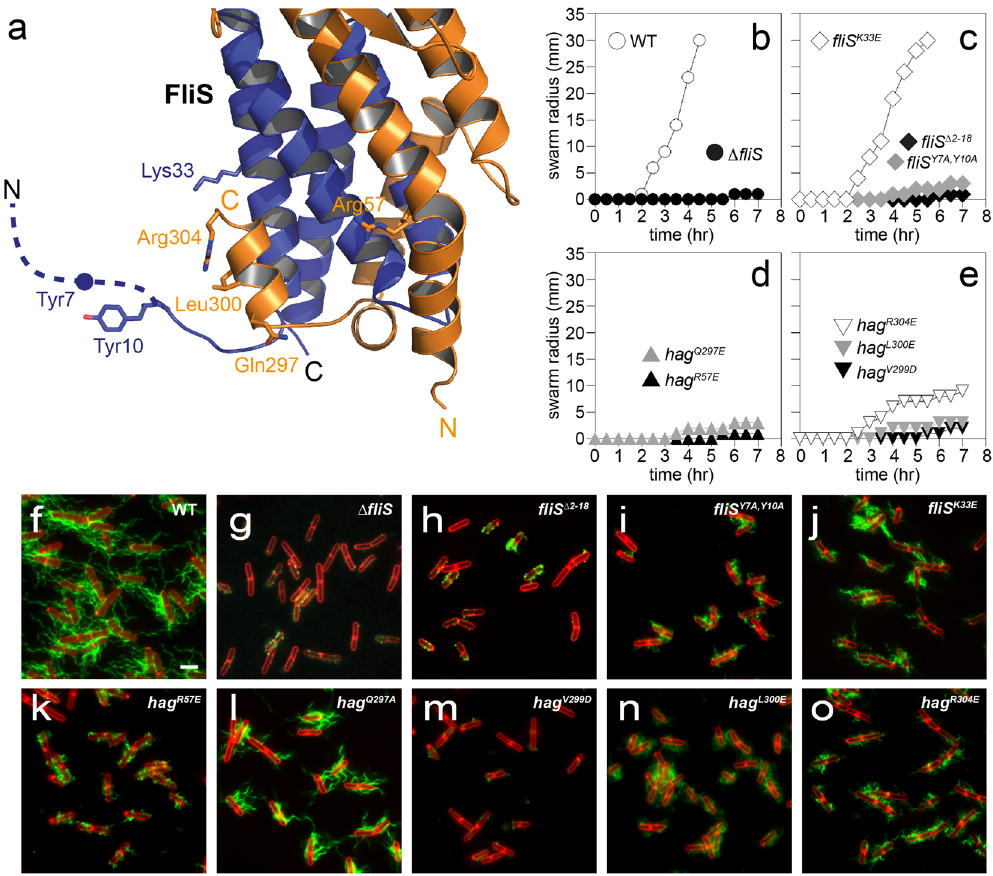
Figure 3. Physiology of flagellin/FliS binding to FlhA-C. ( a ) Projection of different amino acid exchanges onto the structure of flagellin/FliS. Flagellin is shown in orange, while FliS is depicted in blue. Dashed lines indicate disordered regions. ( b – e ) Quantitative swarm expansion assay for fliS and flagellin ( hag ) mutants: WT is swarming proficient and covers a 0.7% LB agar plate in about 4.5 hours but Δ fliS is non-swarming. Both fliS Δ 2–18 and fliS Y7A , Y10A phenocopy a Δ fliS mutant for swarming. fliS K33E is swarming proficient. hag R57E confers a non-swarming phenotype while all hag mutants except hag V299D show almost no swarming motility. ( f – o ) Fluorescence microscopy of B . subtilis filaments shows deficiency of Δ fliS , fliS Δ 2-18 and fliS Y7A , Y10A mutants to secrete flagellin. fliS K33E shows short flagellar filaments. hag R57E , hag V299D , hag L300E and hag R304E show almost no flagellar filaments, while hag Q297A exhibits short flagellar filaments. Scale bars are 2 µ